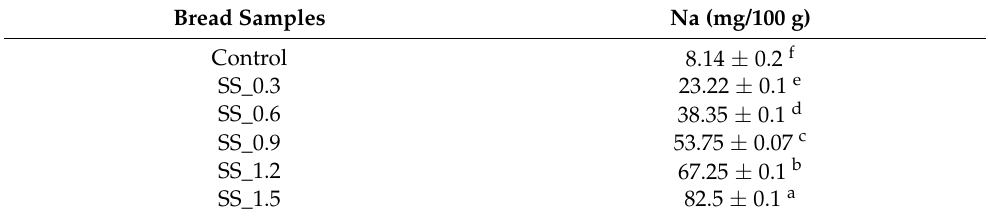
Table 8. Sodium content of the bread samples with different levels of sea salt with low sodium content (SS) additions.